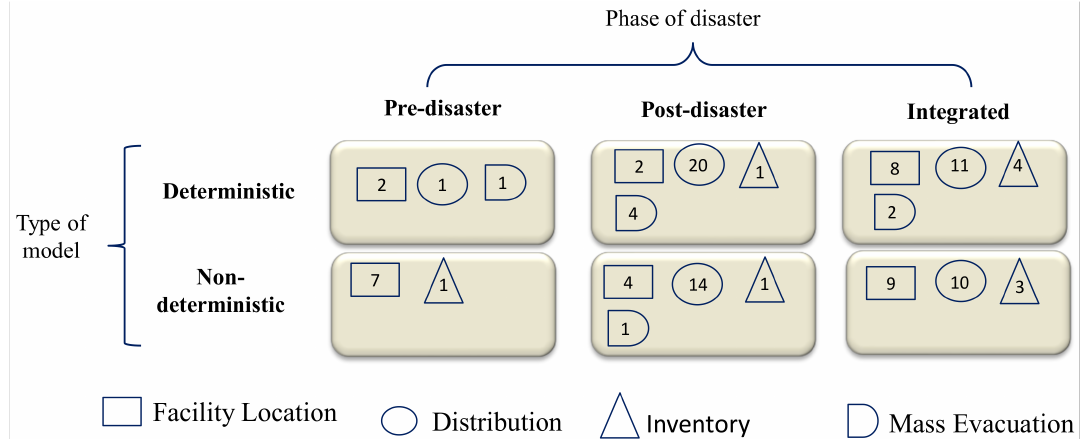
Figure 6. Classification of problem type, model type and phase of a